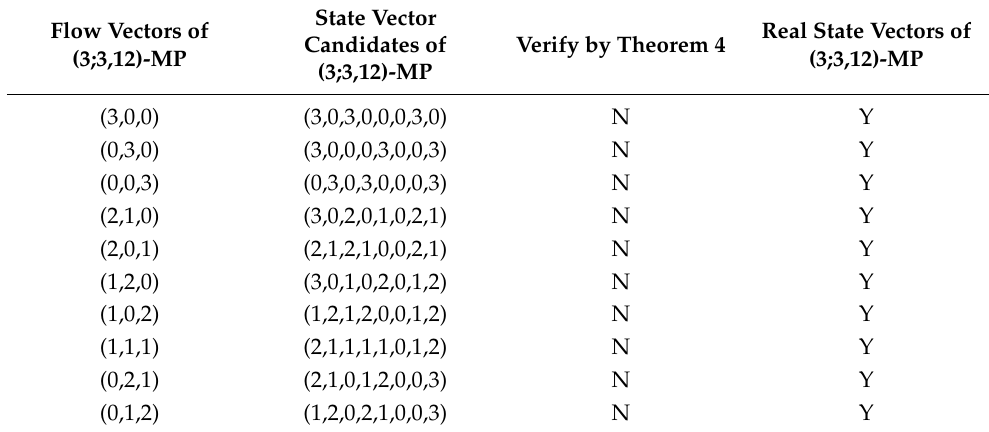
Table 8. The real (3;3,12)-MP state